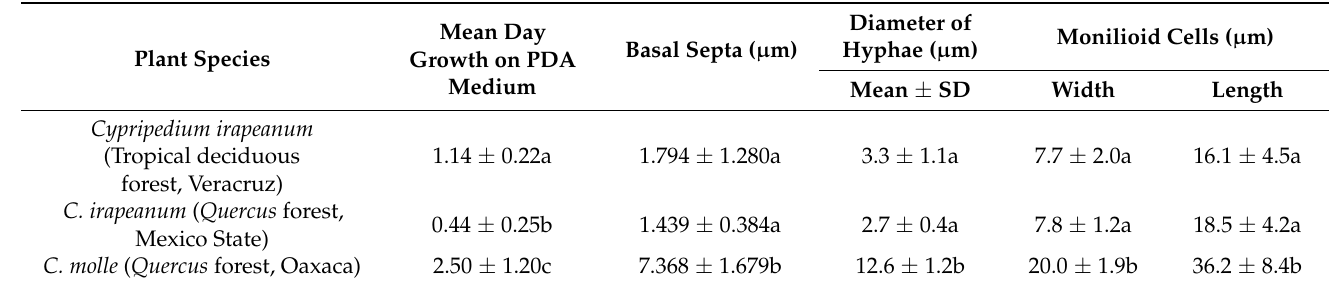
Table 1. Micromorphological characteristics of Cypripedium spp. Mycorrhizal endophytes (mean ± standard deviation). Different letters represent significant differences at p ≤ 0.05. See Figure